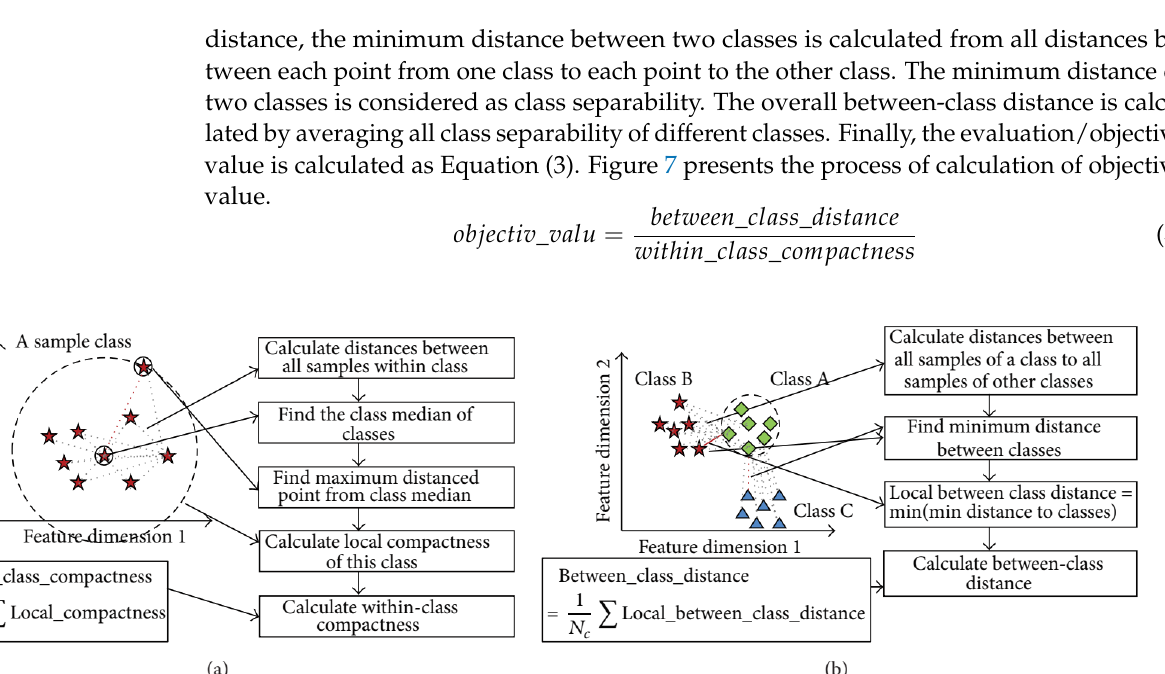
Figure 7. Process of objective value calculation: ( a ) Within-class compactness ( b ) between-class distance.